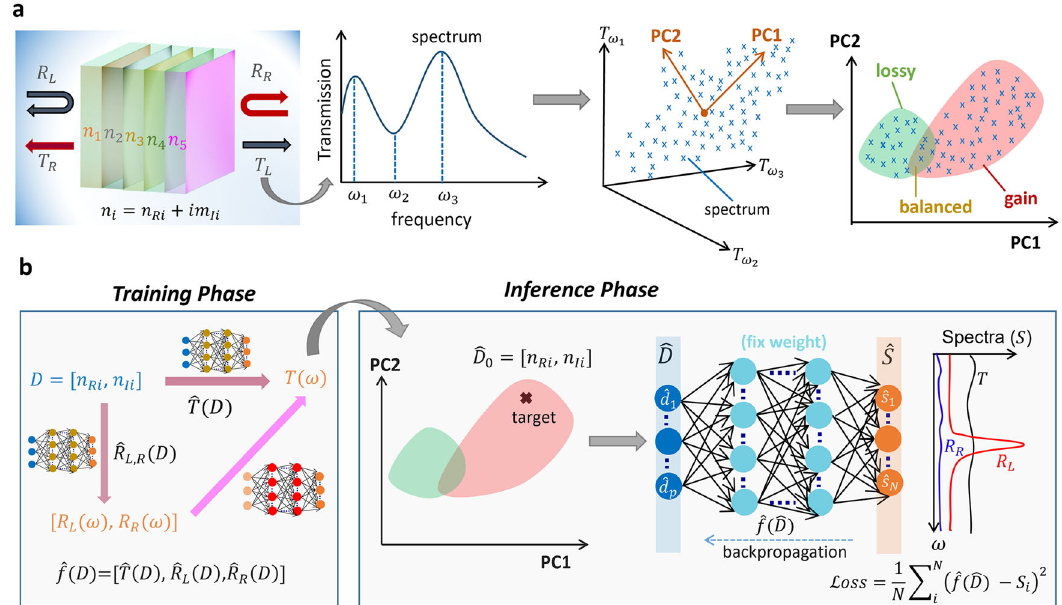
Fig. 1 Conceptual illustration of the design process for machine learning assisted non-Hermitian photonics structures. a Dimensionality reduction based on Principal Component Analysis (PCA) reveals the lower-dimensional sub-spaces where gain, lossy, and balanced system reside. A high dimensional transmission spectrum generated from a periodic fi ve-layer photonic structure, of complex refractive index n i ¼ n Ri þ in Ii , where n R and n I are the real and the imaginary parts, whose unit-cell is shown, is mapped to a point. The latent space for different spectra (left re fl ection and transmission R L and T L and right re fl ection and transmission R R and T R ) forms feasible regions of gain, lossy, and balanced systems spanned by the fi rst two principal components (PC1 and PC2). b For the inverse design, the dimensionality of the desired response (transmission) is reduced using PCA to observe the feasibility of the response with effective gain, lossy, and balanced media. Using a trained neural network (NN) that relates the design space with the response space, we search for the optimum solution with adaptive gradient descent method. The nearest neighbor of the target response within the possible region is used as a starting point to optimize the fi nal structure. ^ D denotes the input whereas ^ S denotes the